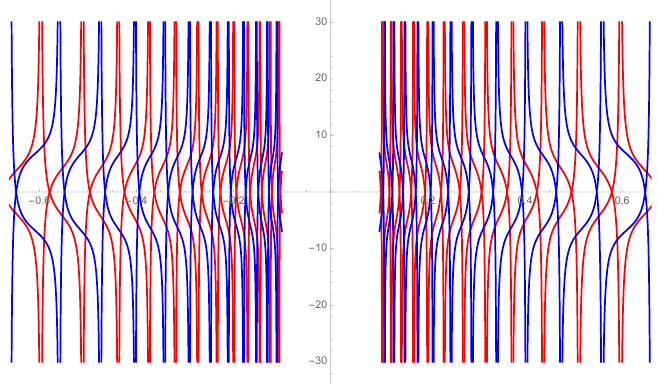
Figure 4 . Eigenvalues of G − 1 (0 , k x , k y = k z = 0) in the holographic NLSM phase as a function of k for M/b ’ 0 . 0014 , in which blue and red curves represent two different sets of eigenvalues x separately. Therefore one concludes that multiple Fermi surfaces exist in the NLSM